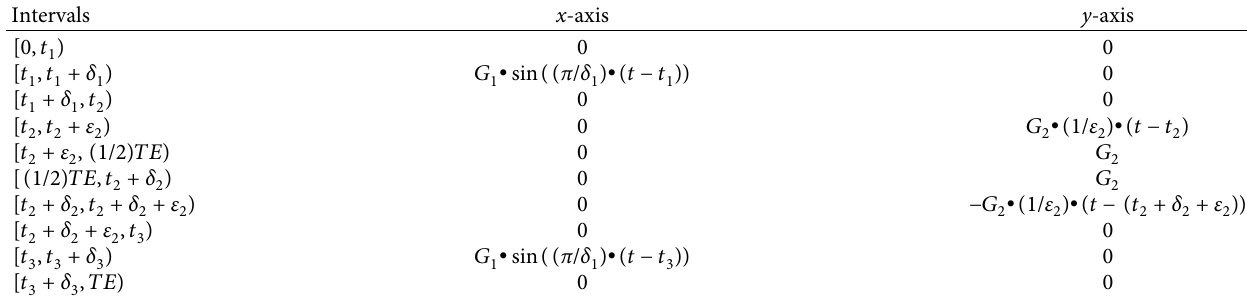
Table 1: Te piecewise function of gradient pulses in Figure